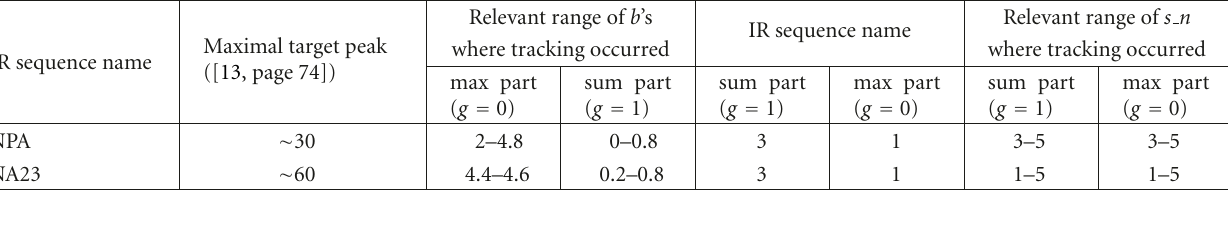
Table 2: Summary of EMCs for which tracking occurred in the IR